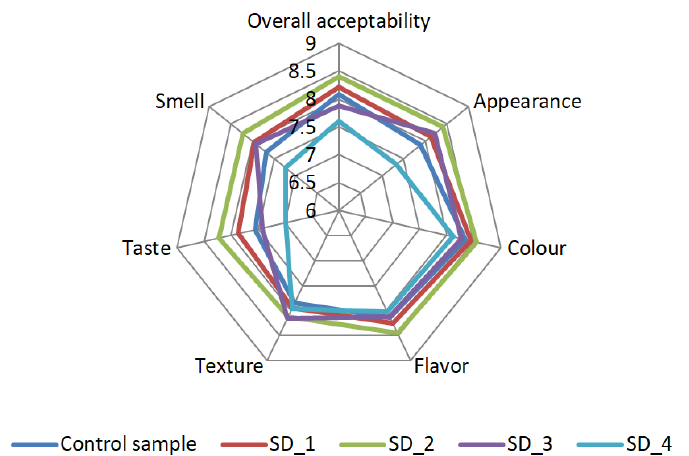
Figure 1. Sensory analysis of bread samples with different levels of dry sourdough (SD) addition.